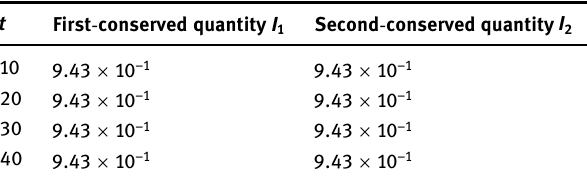
Table 4: Presentation of conserved quantities for = h 0.2 , = N 501 , = δ 0.5 , = β 1 , = ν